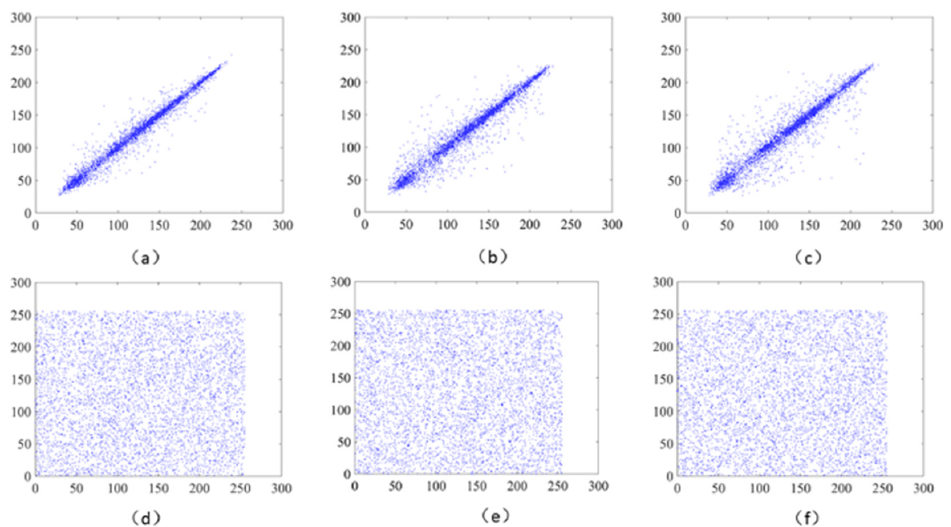
Figure 7. ( a ) horizontal of plain image; ( b ) vertical of plain image; ( c ) diagonal of plain image; ( d ) horizontal of cipher image; ( e ) vertical of cipher image; ( f ) diagonal of cipher image. Table 4. Information entropy analysis result of encrypted image. Image Ours Ref. [55] Ref.